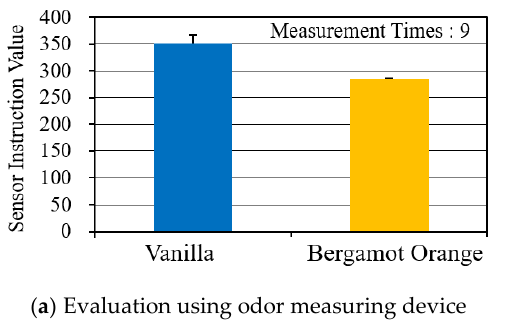
Figure 2. Strength of presented smell.